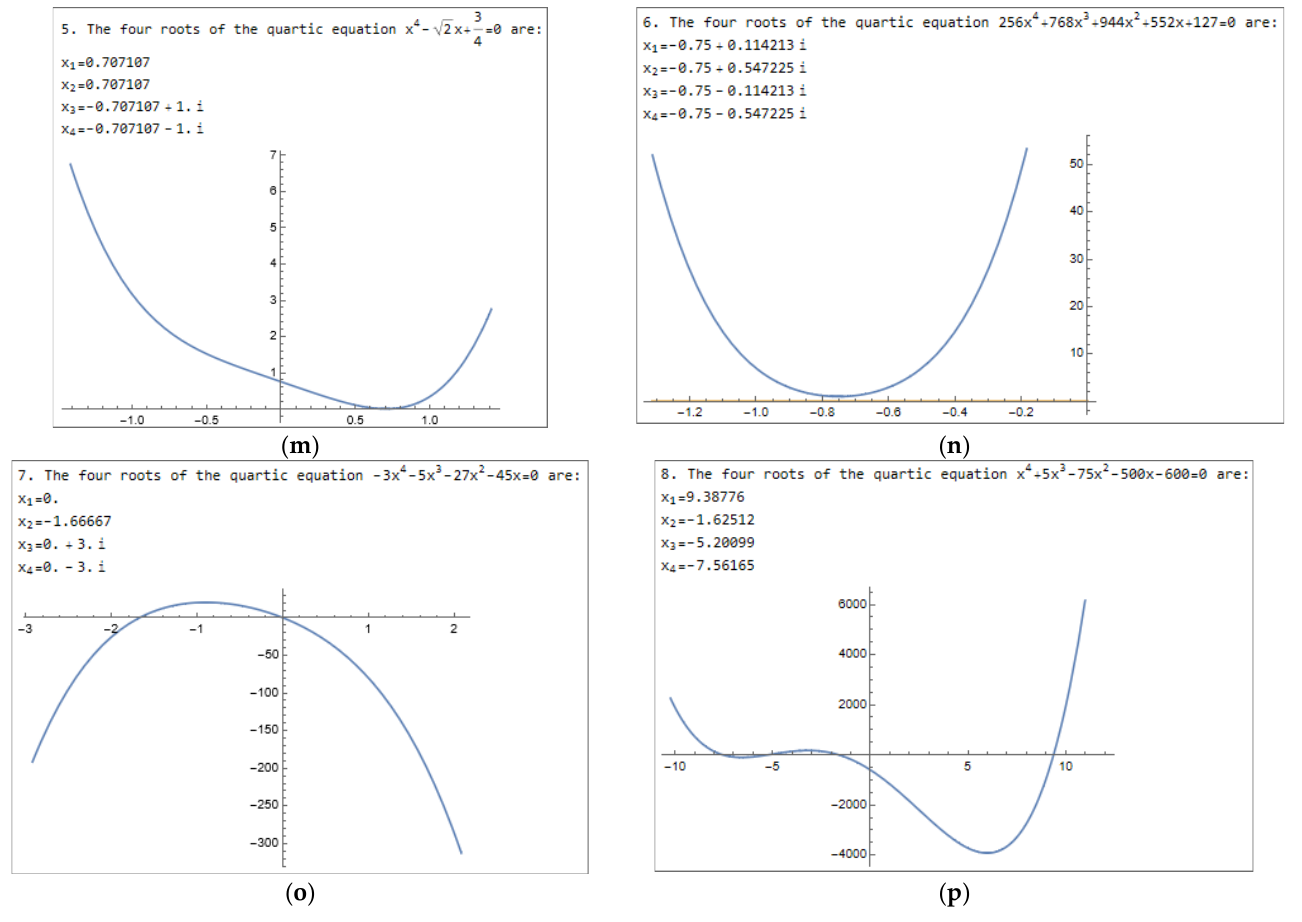
Figure 2. Examples of different cases of the SDE, the GCE and the GQE: ( a ) Case of the SDE with b 2 − 4 ac > 0. ( b ) Case of the SDE with b 2 − 4 ac = 0. ( c ) Case of the SDE with b 2 − 4 ac < 0. ( d ) Case of the GCE with only two multiple roots. ( e ) Case of the GCE with three multiple roots. ( f ) Case of the GCE with purely imaginary roots. ( g ) Case of the GCE with zero as a non-multiple root. ( h ) Case of the GCE with non-multiple roots other than zero. ( i ) Case of the GQE with four multiple roots. ( j ) Case of the GQE with three multiple roots. ( k ) Case of the GQE with a pair of two different couples of multiple roots. ( l ) Case of a biquadratic equation with only two multiple roots. ( m ) Case of a non-biquadratic equation with only two multiple roots. ( n ) Case of a biquadratic equation without multiple roots. ( o ) Case of the GQE with zero as a non-multiple root and a couple of purely imaginary roots. ( p ) Case a non-biquadratic quartic equation with non-multiple roots other than zero.